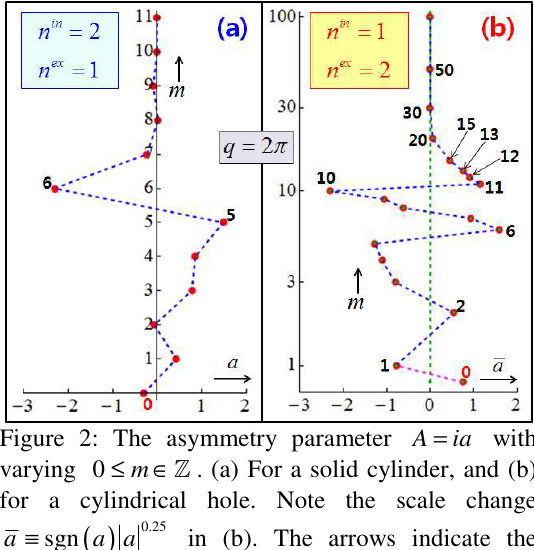
Figure 2: The asymmetry parameter A ia = with varying 0 m ≤ ∈ (cid:3) . (a) For a solid cylinder, and (b) for a cylindrical hole. Note the scale change ( ) 0.25 sgn a a a ≡ in (b). The arrows indicate the direction of increasing m .